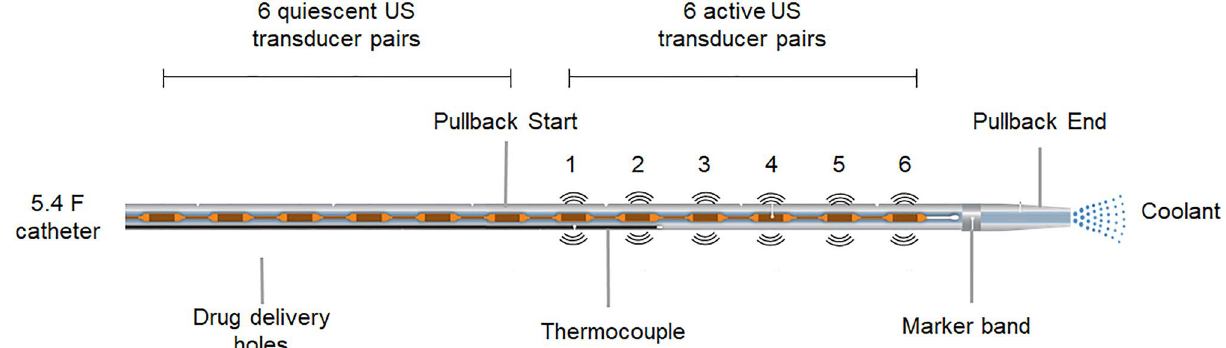
Figure 8. Schematic of EkoSonic catheter drug delivery hole and transducer layout. Along the 12 cm treatment zone of the catheter, the first six ultrasound transducer pairs were quiescent while the distal six transducer pairs were active and insonified the echogenic liposomes. The first drug delivery hole was located 0.5 cm after the first of six quiescent transducer pairs (modified from Lafond et al. 22